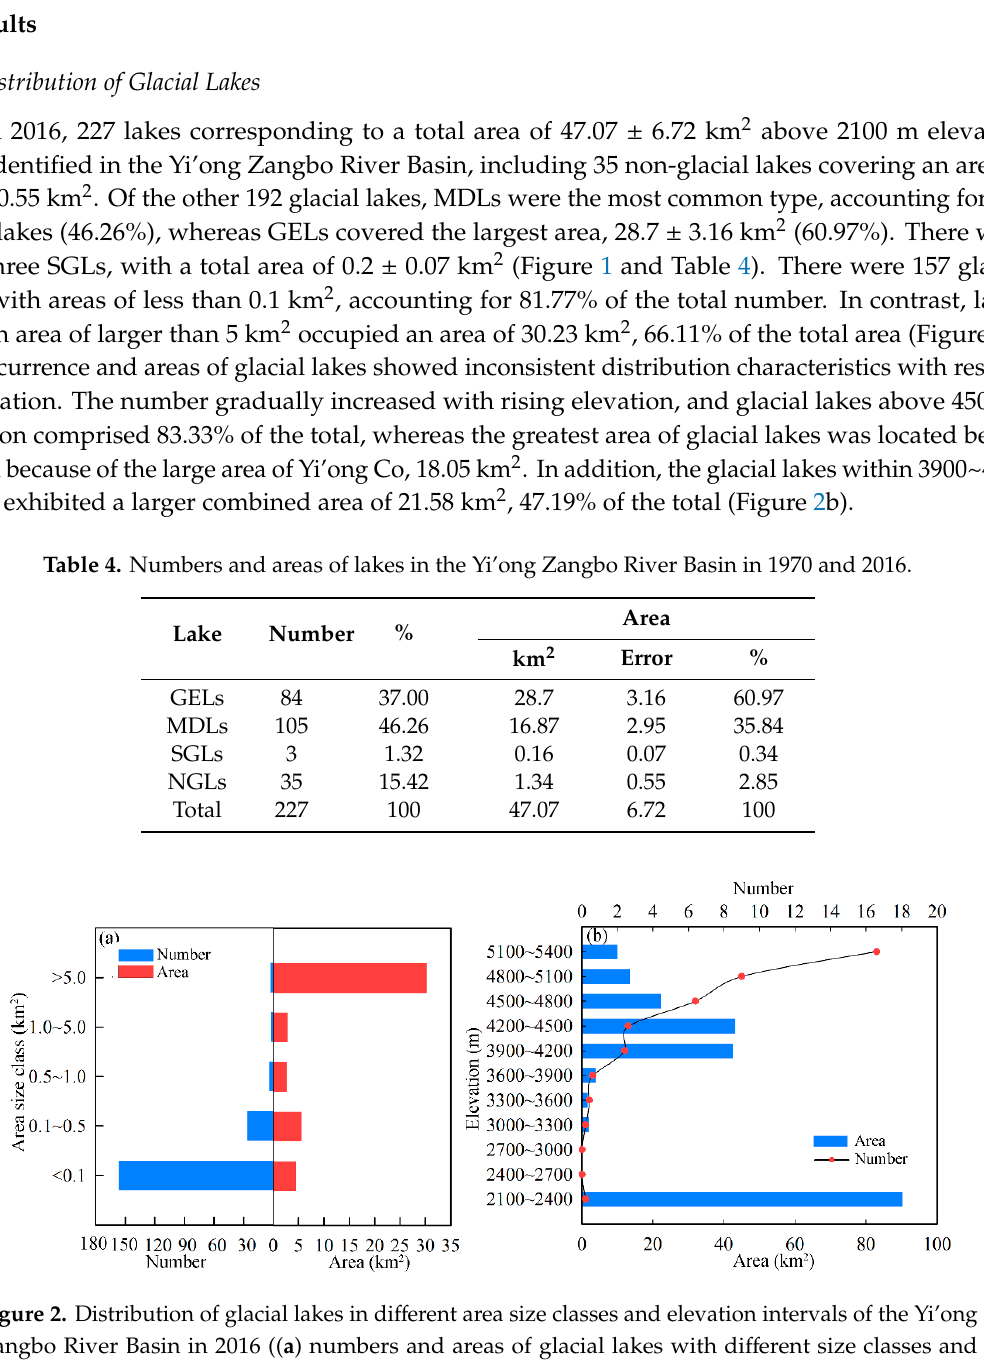
Table 3. Interval division of indicators and the calculated danger value for each interval. Indicators I II III Danger value (V) 0.25 Area of the mother glacier (km 2 ) < 0.5 0.5~2.0 2.0~6.0 > 6.0 Distance between the lake and glacier terminus (m) > 600 300~600 50~300 < 50 Slope between the lake and glacier ( ◦ ) < 12 12~15 15~19 > 19 Mean slope of the moraine dam ( ◦ ) < 12 12~17 17~22 > 22 Snout steepness of the mother glacier ( ◦ ) < 9 9~12 12~18 >18